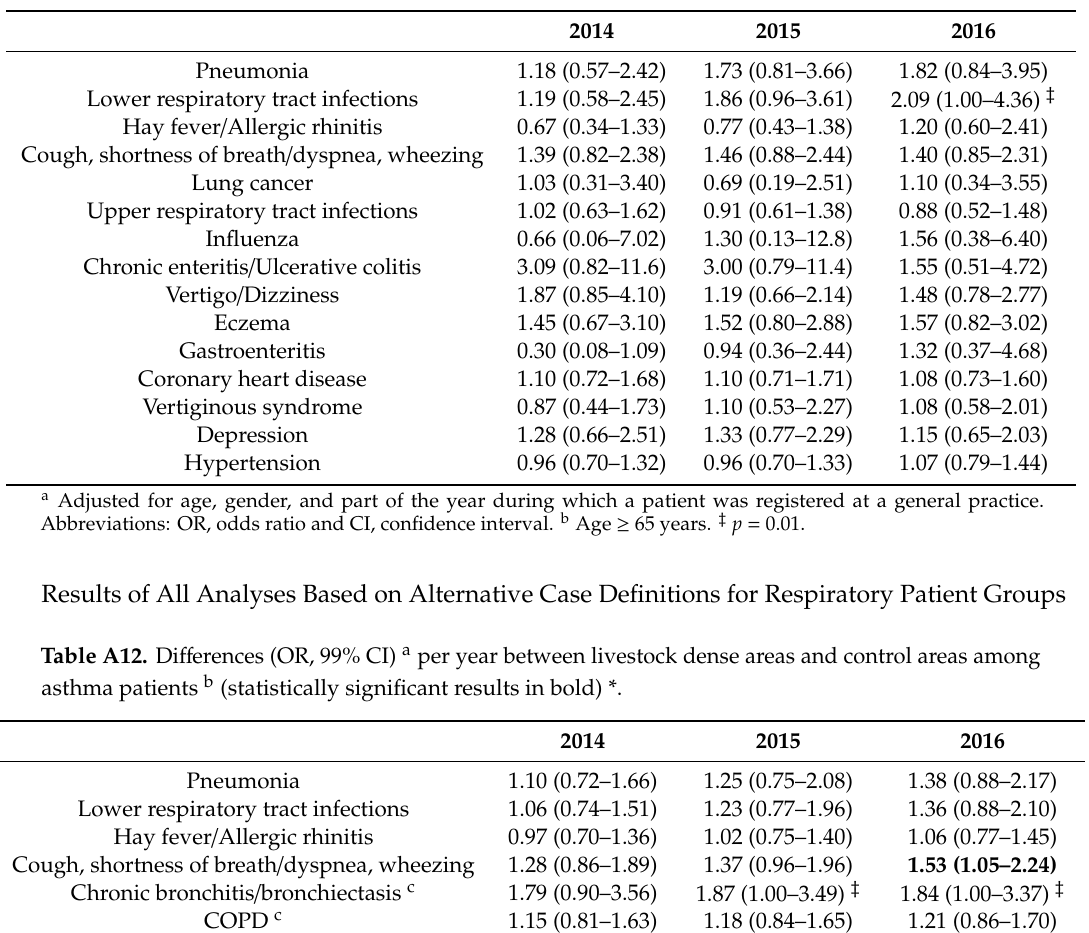
Table A11. Di ff erences (OR, 99% CI) a per year in various comorbid conditions between livestock dense areas and control areas among elderly asthma patients b , without comorbid COPD.